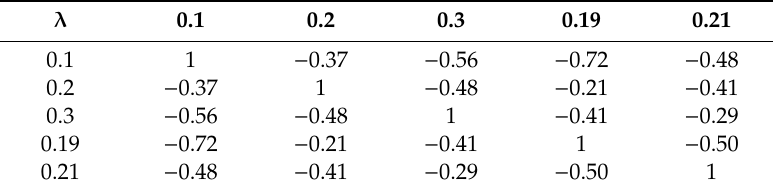
Table A12. The Pearson correlation coe ffi cients of the di ff erent values of λ when the edges were smoothed using FID. It confirms that our sample accuracy was independent.